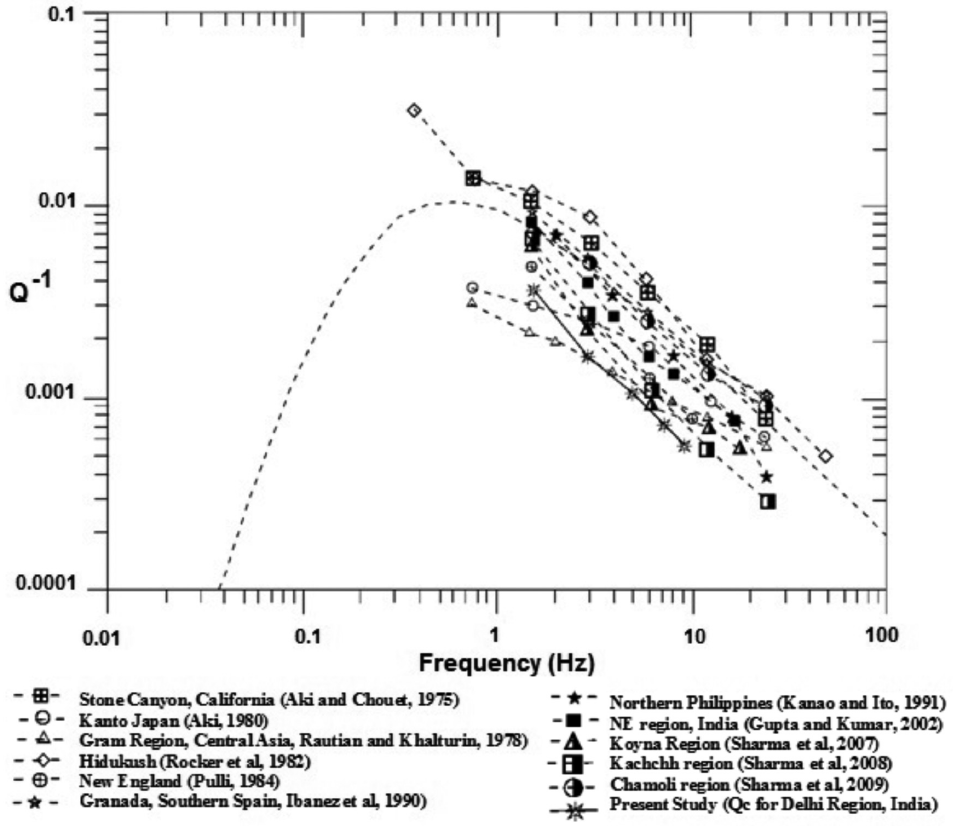
Figure 7. Comparison of present estimates of Q